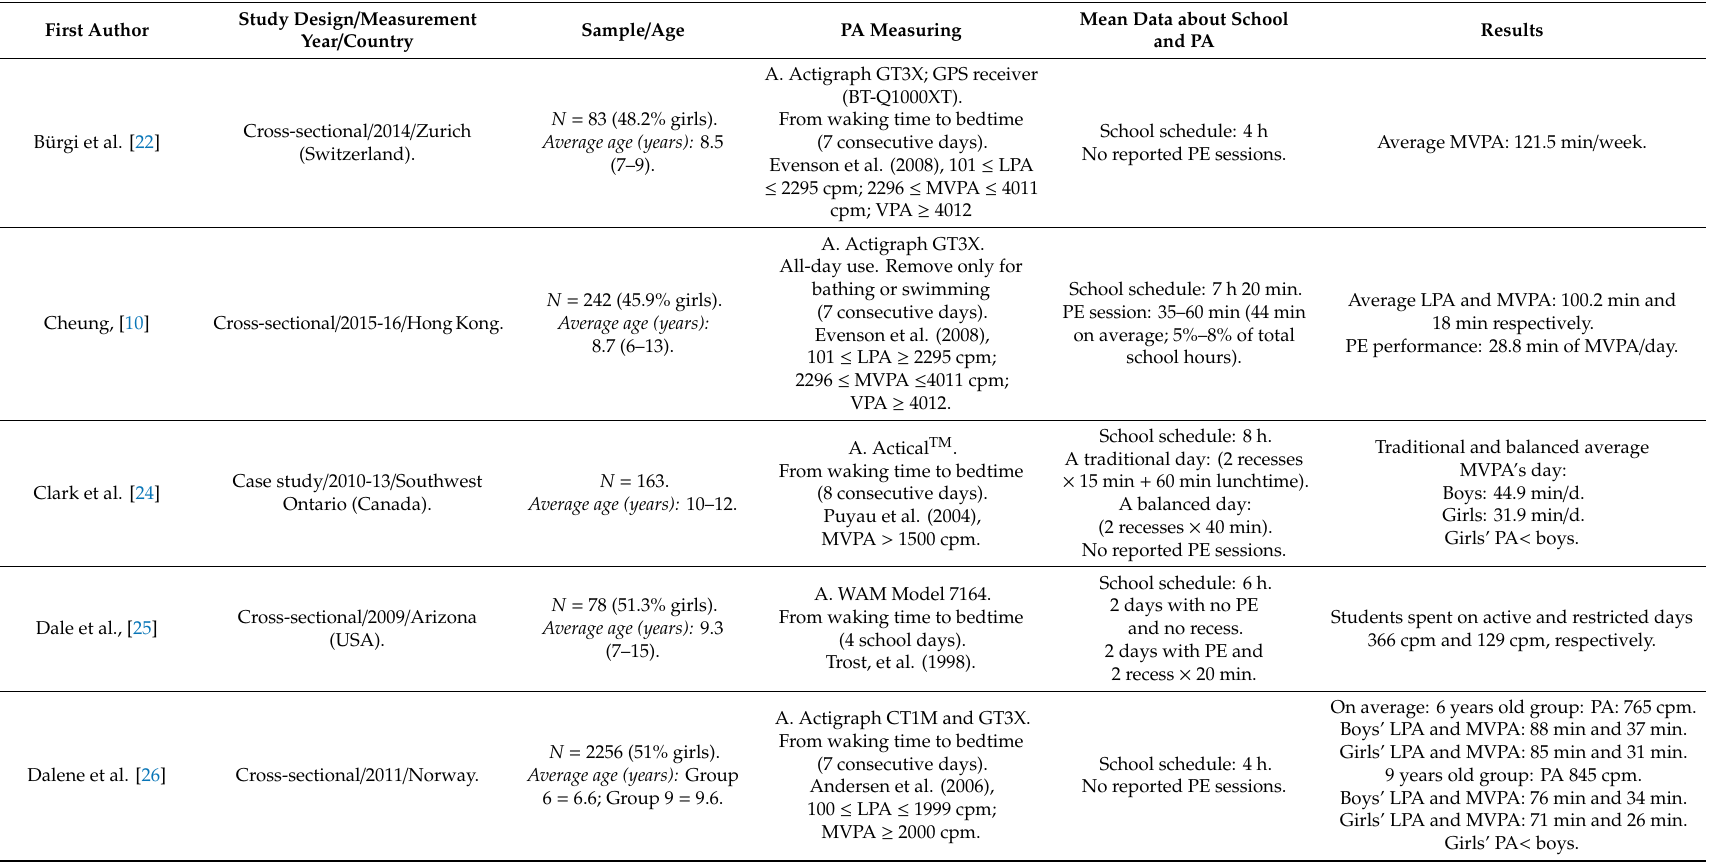
Table 3. Characteristics of the analyzed studies with participants of primary